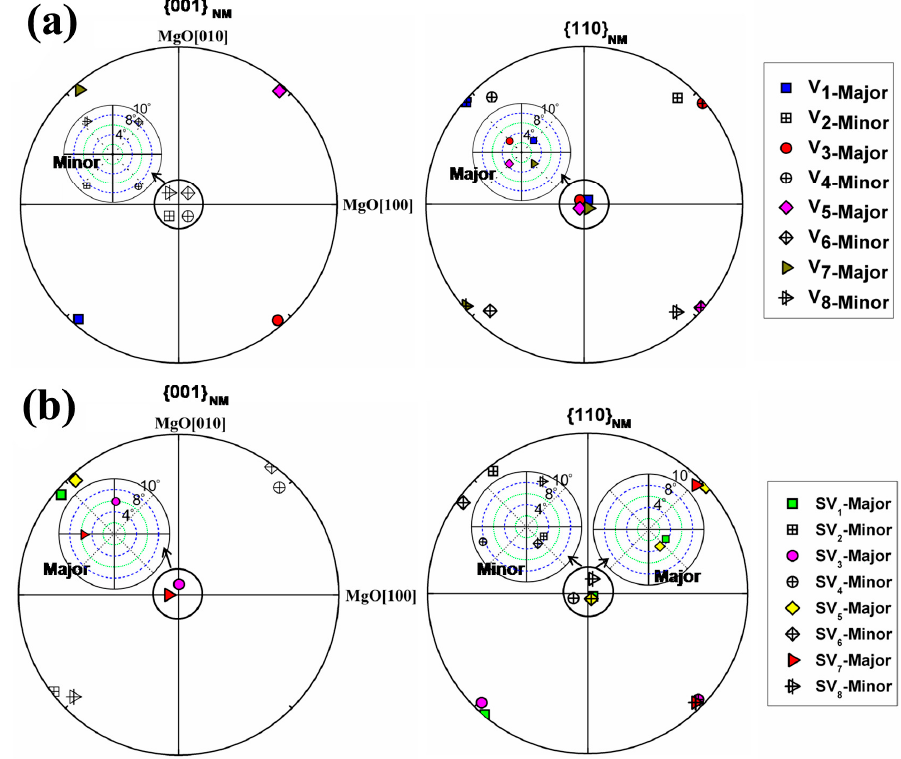
Figure 16. ( a ) {0 0 1} NM and {1 1 0} NM pole figures of NM variants in Z 1 zone; and ( b ) {0 0 1} NM and {1 1 0} NM pole figures of NM variants in Z 2